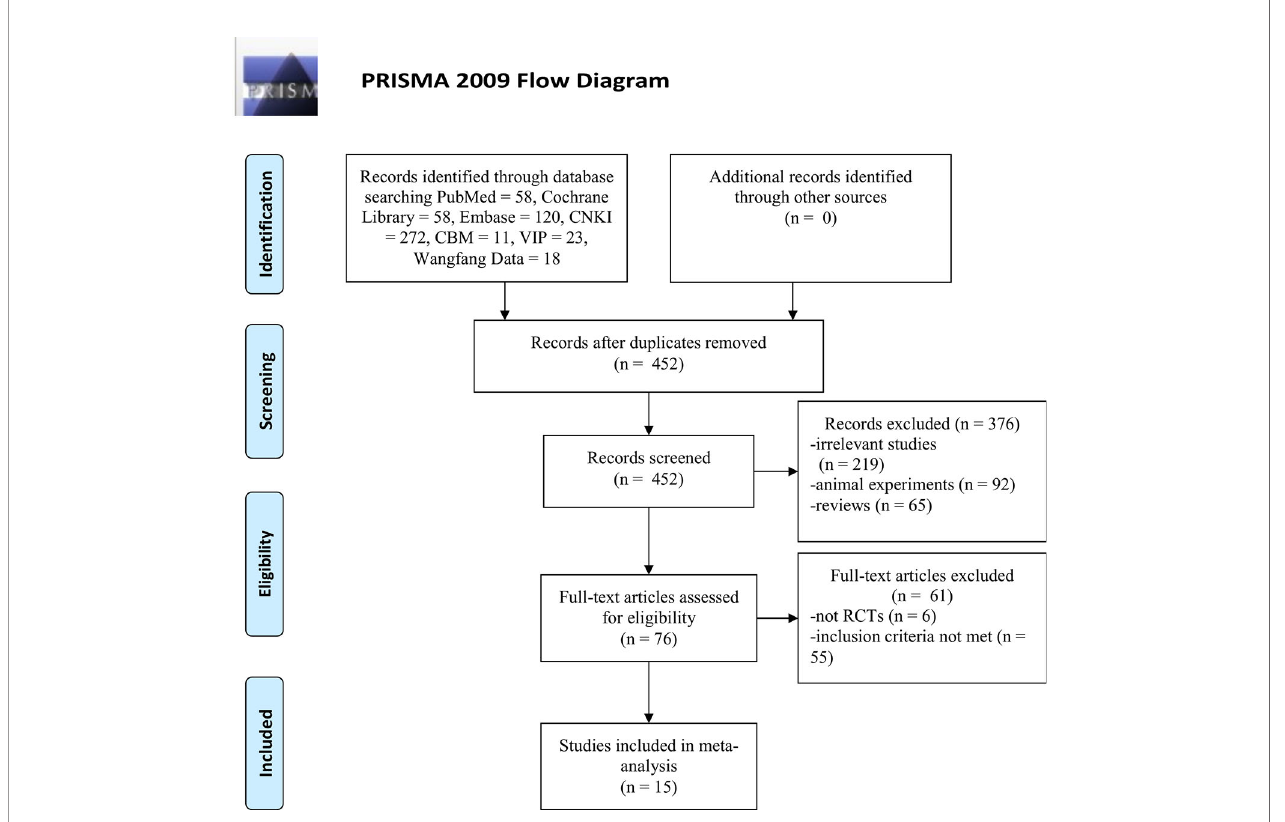
FIGURE 1 | PRISMA 2009 Flow